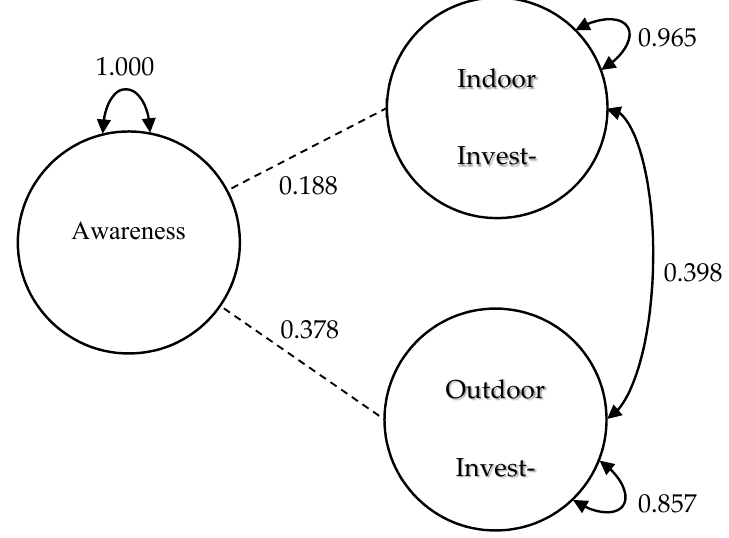
Figure 5. Model of owning water-saving appliances for indoor and outdoor usage regressed on awareness of water supplies for well owners without municipal connections ( n = 141).